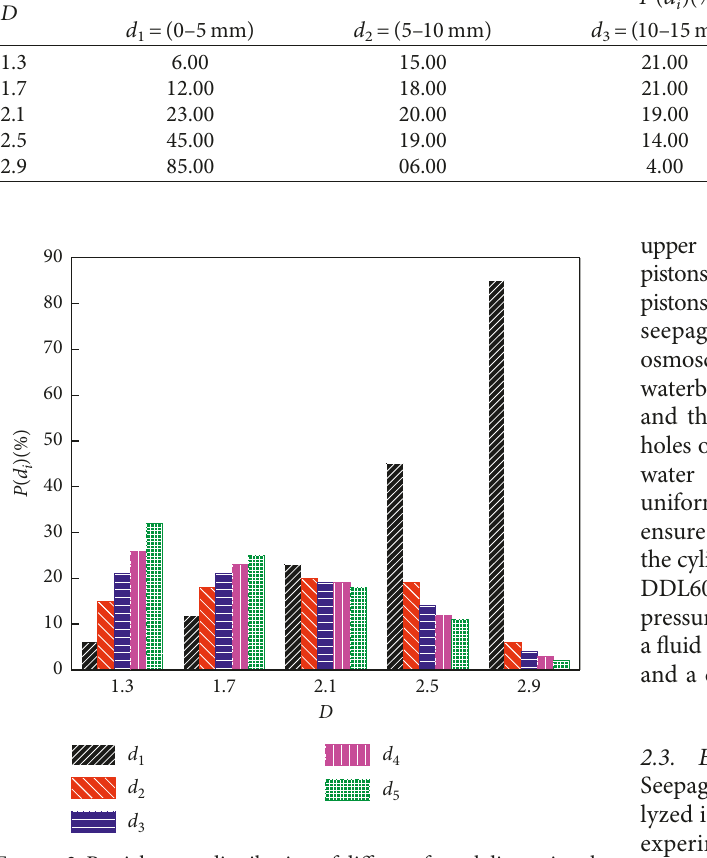
Figure 2: Particle mass distribution of different fractal dimensional gradation